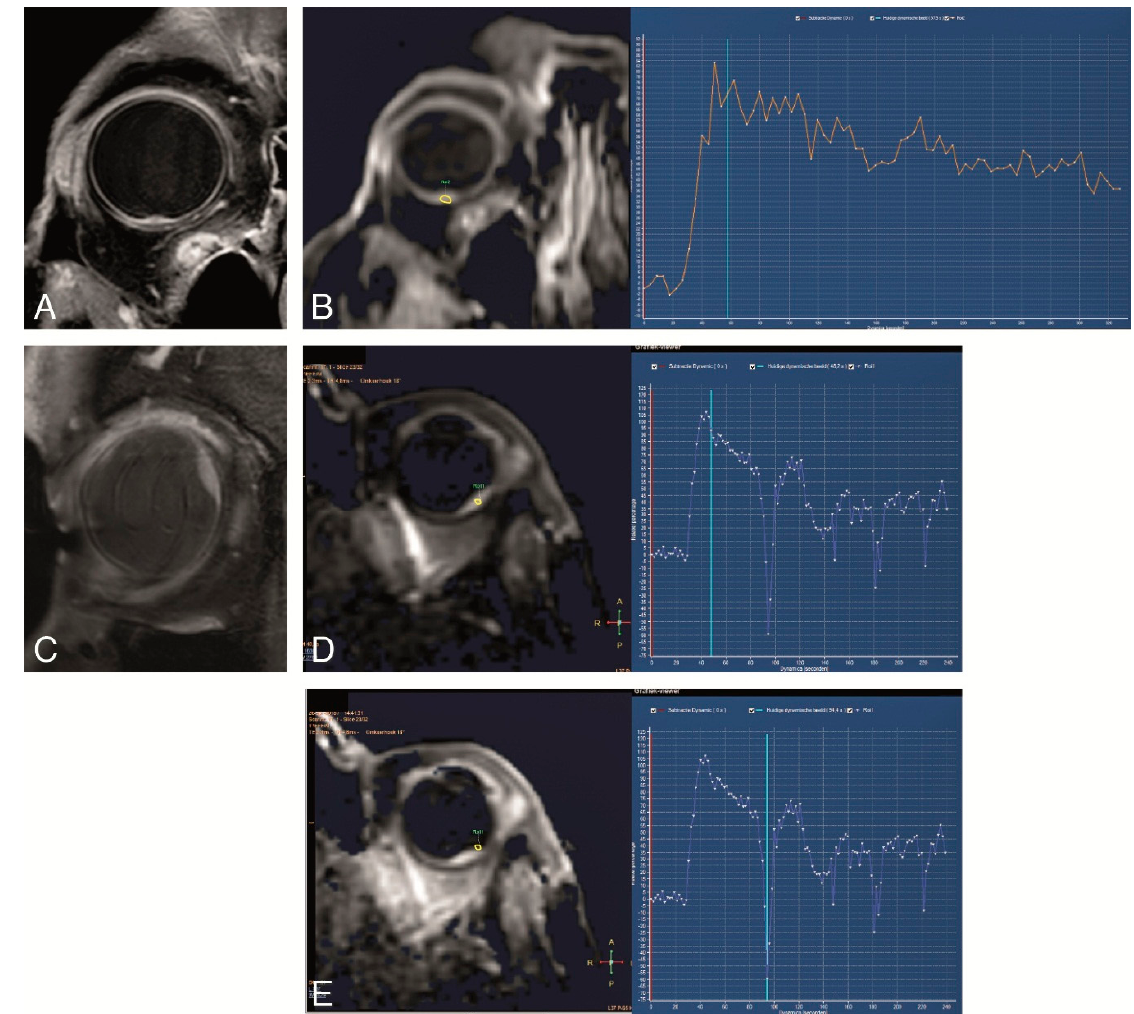
Figure 9. ( A – E ) DCE in two different patients. ( A , B ) Good DCE in a small tumor, with few movement artefacts and a wash-out TIC pattern. ( C – E ) DCE in a small uveal melanoma. Although with